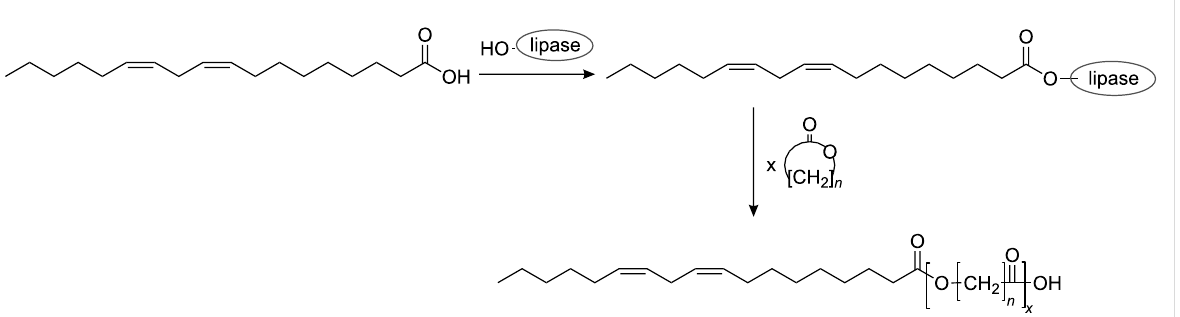
Figure 5: Enzymatic reactions in miniemulsion droplets (reproduced with permission from [91]. Copyright (2003) Wiley-VCH Verlag GmbH & Co, KGaA). EAM = enzyme-activated